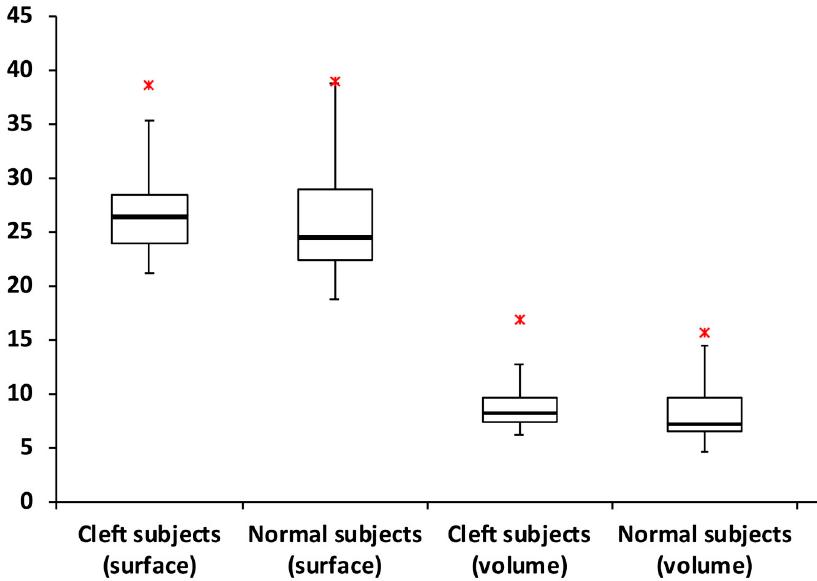
Figure 8. Box plot demonstrating the distribution of values for nasal area surface and nasal volume measurements. No significant differences were observed for comparisons between patients with bilateral cleft lip and palate and normal subjects. Red asterisks indicate maximum outliers’ values ( n = 1 for each group). Table 4. Intergroup comparative analysis between patients with bilateral cleft lip and palate and normal subjects.